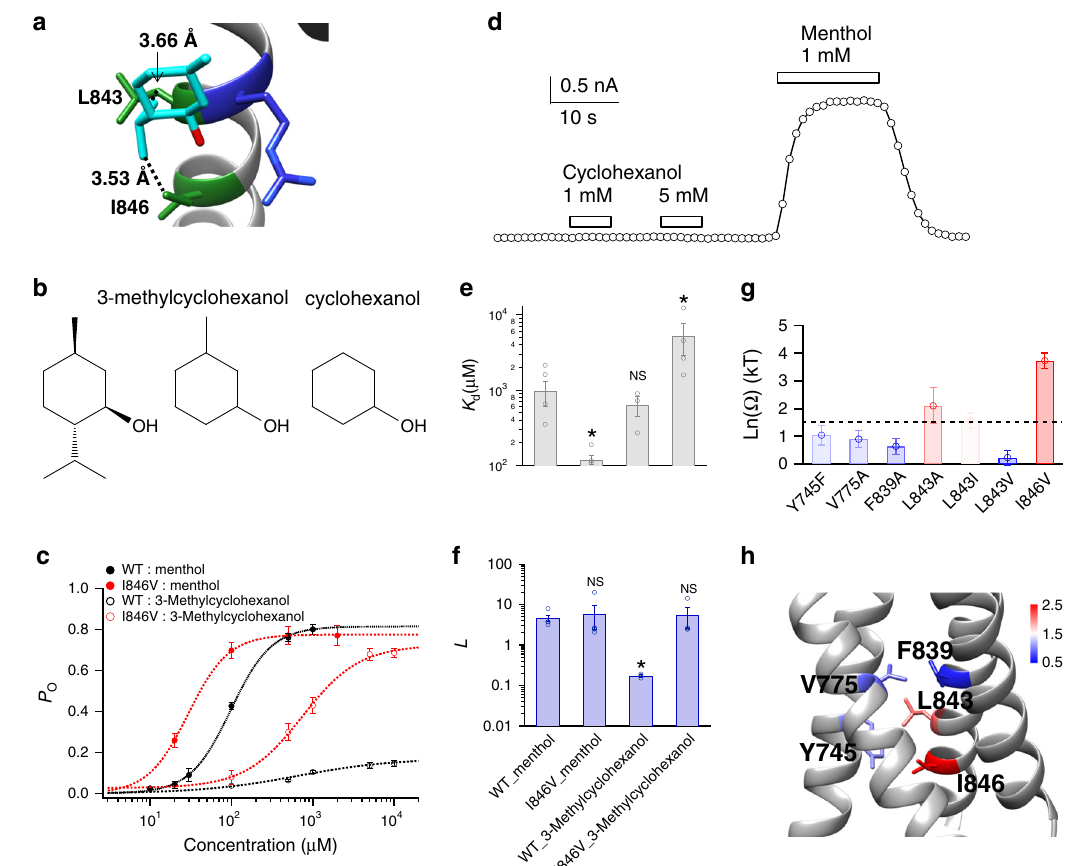
Fig. 3 Speci fi c interactions between menthol isopropyl legs and the channel probed with 3-methylcyclohexanol. a Docking predicted that the isopropyl legs of menthol stand on hydrophobic residues through VDW interactions (dashed lines in black: C9 atom of menthol to CD1 atom of I846: 3.53 Å; C8 atom of menthol to CB atom of L843: 3.66 Å). b Chemical structures of menthol, 3-methylcyclohexanol lacking the isopropyl legs, and cyclohexanol where both the isopropyl and methyl moieties are missing compared to menthol. c The concentration – response curves of wild type and mutant such as I846V with either menthol or 3-methylcyclohexanol were measured with whole-cell patch-clamp recordings ( n = 3 – 5). d Representative whole-cell patch-clamp recording showed that cyclohexanol up to 5 mM cannot activate TRPM8 channel. e , f For wild type and I846V channel, K d and L values were calculated from the concentration – response curves in c (two-sided t -test, * p < 0.05; NS not statistically signi fi cant). g Summary of coupling energy measurements. Coupling energy value was calculated from the K d values. Mutants showing a coupling energy larger than 1.5 kT (dashed line) were colored in red. Those with less energy were colored in different shades of blue. At least four independent trials were performed for each chemical at each concentration. h Spatial distribution of coupling energy values within the menthol-binding pocket. Color scheme is the same as in g . Color scale is in the unit of kT. All statistical data are given as mean ± s.e.m. Source data are provided as a Source Data fi